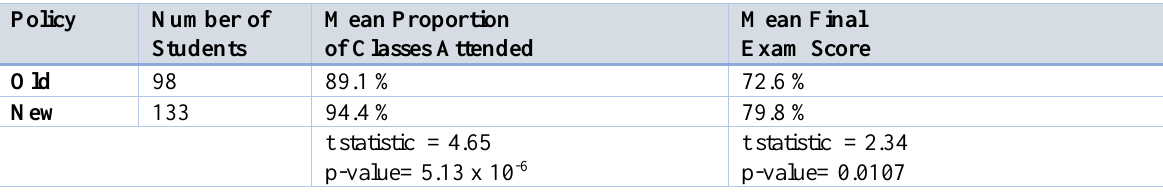
Mean Proportion of Classes Attended and Mean Final Exam Scores for General Chemistry